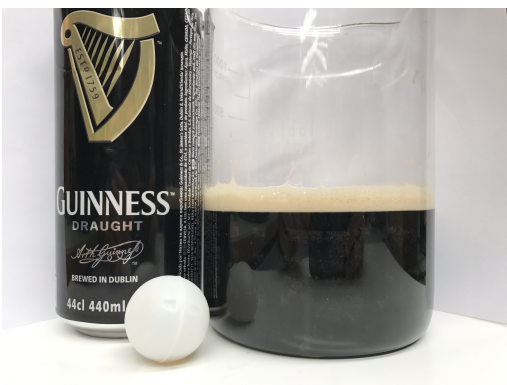
Figure 3. Widget inside a Guinness can. The hollow ball is filled up with pressurized gas at the same pressure than the can. When the can is opened, the widget breaks and generates a turbulent gas jet that introduces the mixing necessary to trigger foam formation.